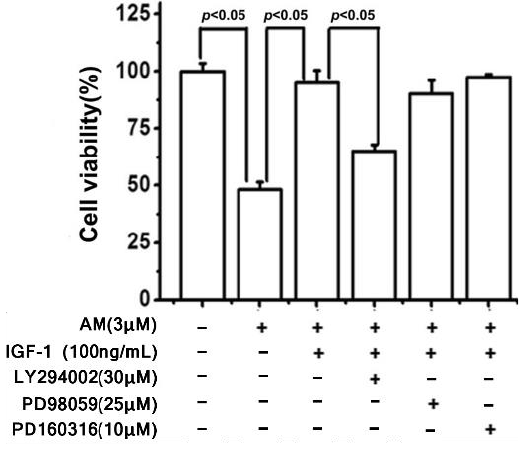
Figure 7. LY294002, a PI3K inhibitor, inhibited the protective effect of IGF-1 against amiodarone- induced apoptosis of RGC cells. The ERK pathway inhibitor PD98059 and p38 MAPK inhibitor PD160316 had no effect. RGC cells were pretreated with either LY294002, PD98059, or PD160316 and then treated with IGF-1 and amiodarone for 24 h. Cell viability was determined by the MTT assay. Data are expressed as a percentage of the corresponding control value which was normalized as 100%. Results show the mean ± SEM and represent assays from five independent experiments [40]. As a final mechanistic investigation, Liao et al. explored the cellular distribution of FoxO3a, a downstream transcription factor of PI3K/Akt. FoxO3a is phosphorylated by Akt, thereby preventing nuclear translocation and activation of apoptotic pathways. By introducing amiodarone to RGCs, the proportion of FoxO3a translocated to the nu- cleus increased, and this effect was successfully attenuated by pretreatment with IGF-1 (Figures 8 and 9).